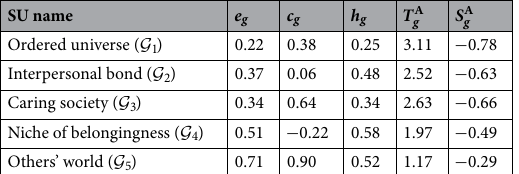
Table 3. Parameter setting for each Symbolic Universe. The values T A g and S A g are evaluated according to equations (2) and (3). The value of T N is 4, while S N = − 1